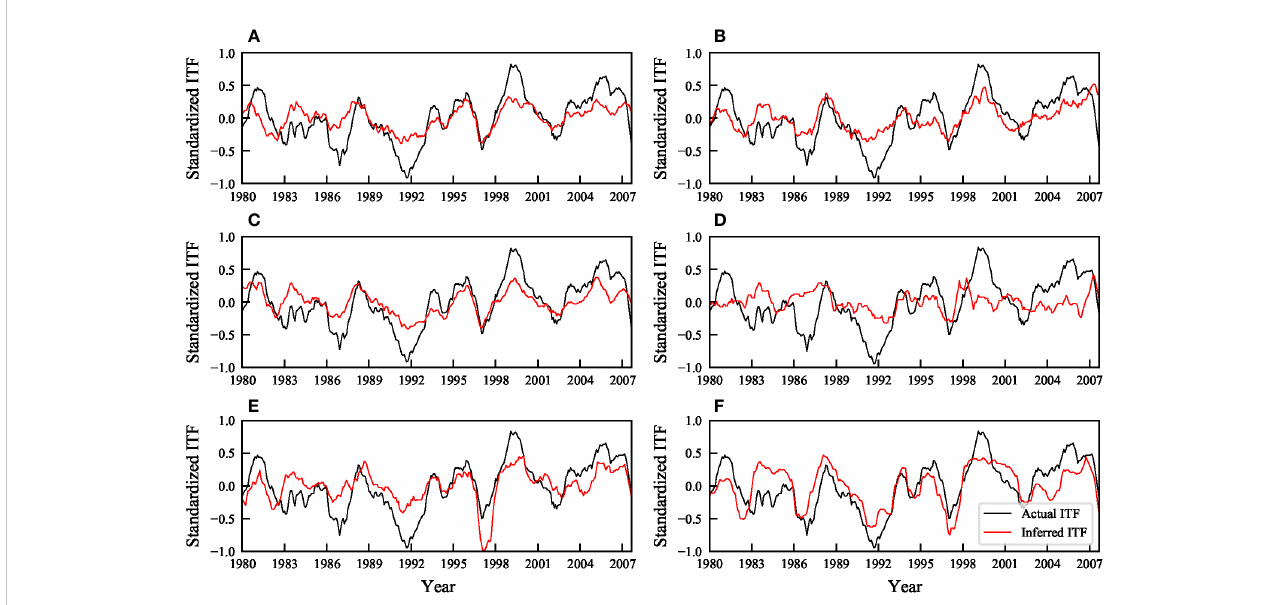
FIGURE 10 Comparison between actual ITF and inferred ITF transport of SODA with different models. (A) CNN. (B) Resnet. (C) Convolutional LSTM. (D) Forest. (E) Logic. (F)